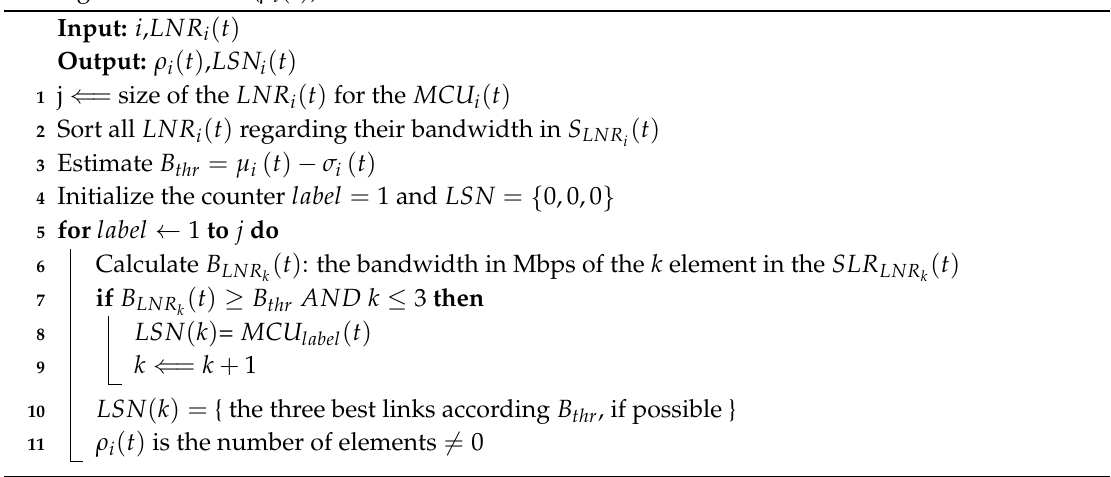
Algorithm 1: Generator function to estimate the list of significant nodes (LSN) and the number of significant nodes ( ρ i ( t )